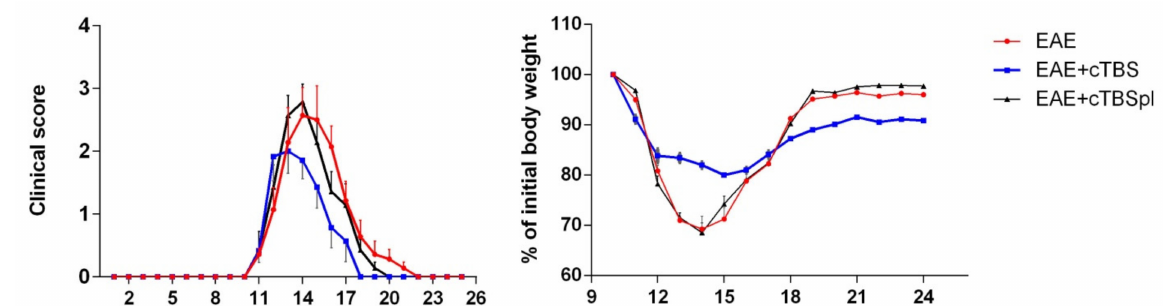
Figure 2. Effects of CTBS treatment on the clinical score of EAE and weight of DA rats. Clinical score and weight of EAE (red circles) in DA rats treated with CTBS protocol (blue square) and CTBS sham noise artifact (black triangles). Animals were monitored from 0 dpi when EAE was induced until 24 dpi when animals were